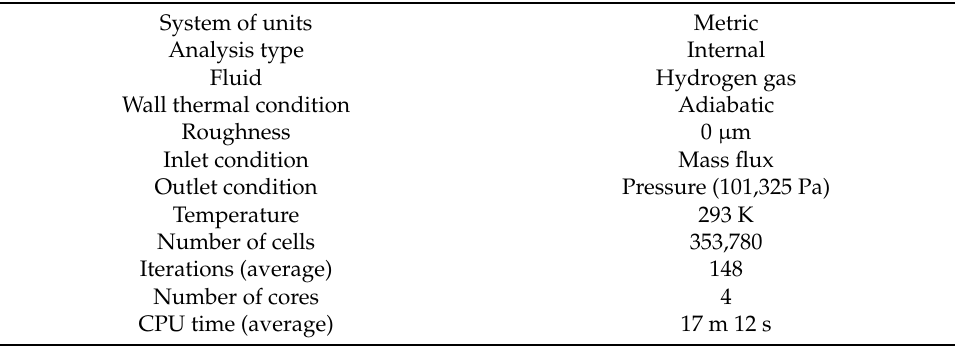
Table 3. Computational fluid dynamics (CFD)